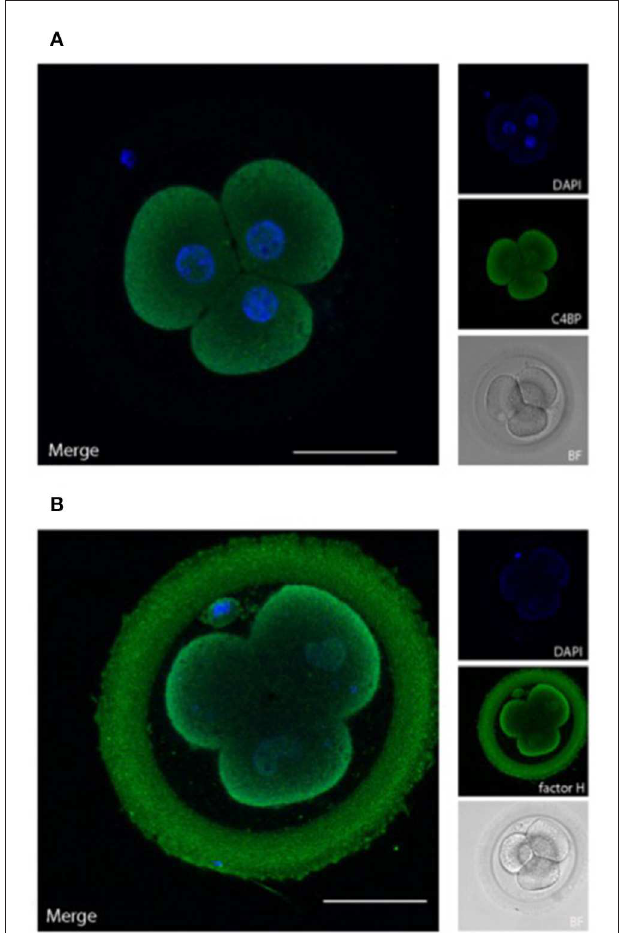
FIGURE 4 | Embryonically bound soluble complement regulators. Human cleavage stage IVF embryos were thawed in Vitrolife G-TL serum-free media. The embryos were incubated with anti-complement antibodies and analyzed by confocal microscopy. Embryonic binding of the soluble complement regulators C4bp and factor H are displayed. (A) C4bp is recruited to the embryonic surface and show strong staining on the cell membrane. No binding is observed to the ZP. (B) Factor H stains both the blastomere surface as well as the ZP. Left panels: single planes, overlay of protein stain (green) and DAPI (blue). Right panels top to bottom: DAPI (blue), protein stain (green), and BF. Scale bars: 50 µ m. For each staining, n = 3 + 5 (2PN + 3PN